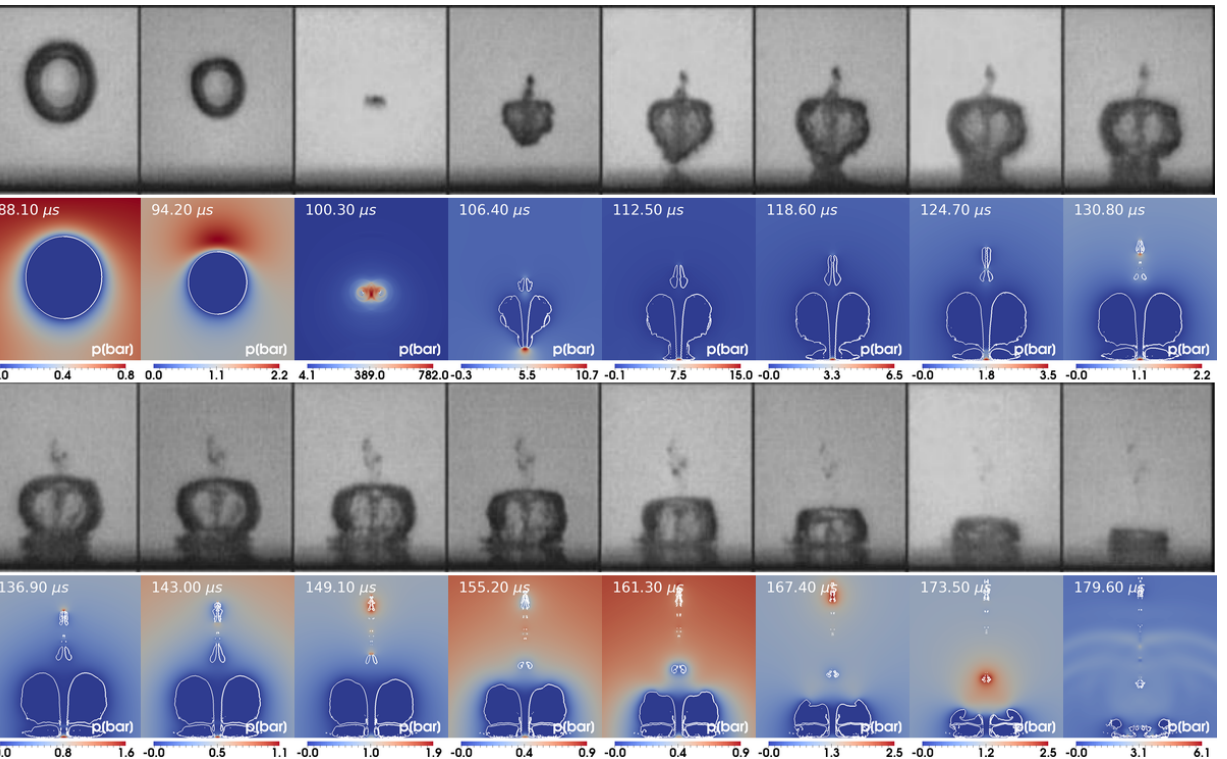
Figure A1. First collapse, rebound and second collapse of a bubble next to a flat solid boundary with D ∗ = 1.6. Comparison of experiments ([12], Figure 2d) and numerical simulations. Experiment: High-speed pictures in gray scale. Time between frames ∆ t exp = 17.7 µ s, R max,exp = 1450 µ m, frame width = 3.9 mm. Numerical simulation: The color represents the pressure in bar. The white line indic- ates the interface (liquid volume fraction α l = 0.5). Time between frames 6.1 µ s, R max,sim = 500 µ m, frame size 1.345mm × 1.42 mm (width × height). The solid boundary is located at the lower border of each frame. Simulation with surface tension set to zero, σ =